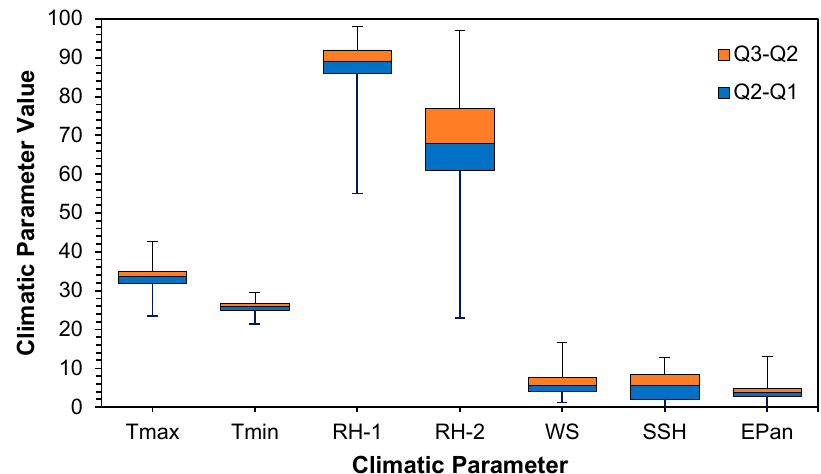
Figure 1. Location map of the study area.